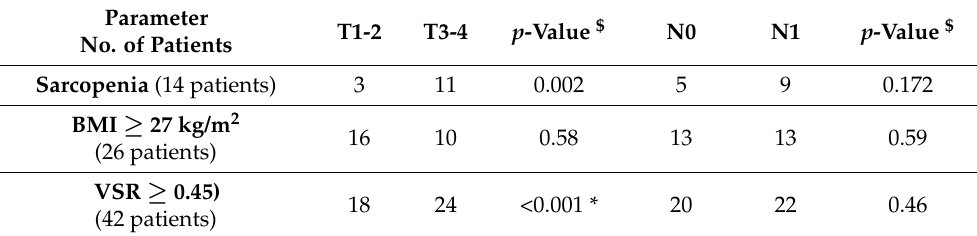
Figure 3. The Kaplan–Meier survival curves showing the difference in OS and CSS for patients with ASCC based on BMI ( ≥ 27 vs. <27 kg/m 2 ) ( a , b ); based on VSR ( ≥ 0.45 vs. <0.45) ( c , d ); based on Sarcopenia (yes vs. no) ( e , f ); and tumor stage (advanced vs. early) ( g , h ), in red and blue, respectively. BMI: body mass index; VSR: visceral-to-subcutaneous fat ratio; univariate analy- sis using the log-rank test. * p -value < 0.05: significant.